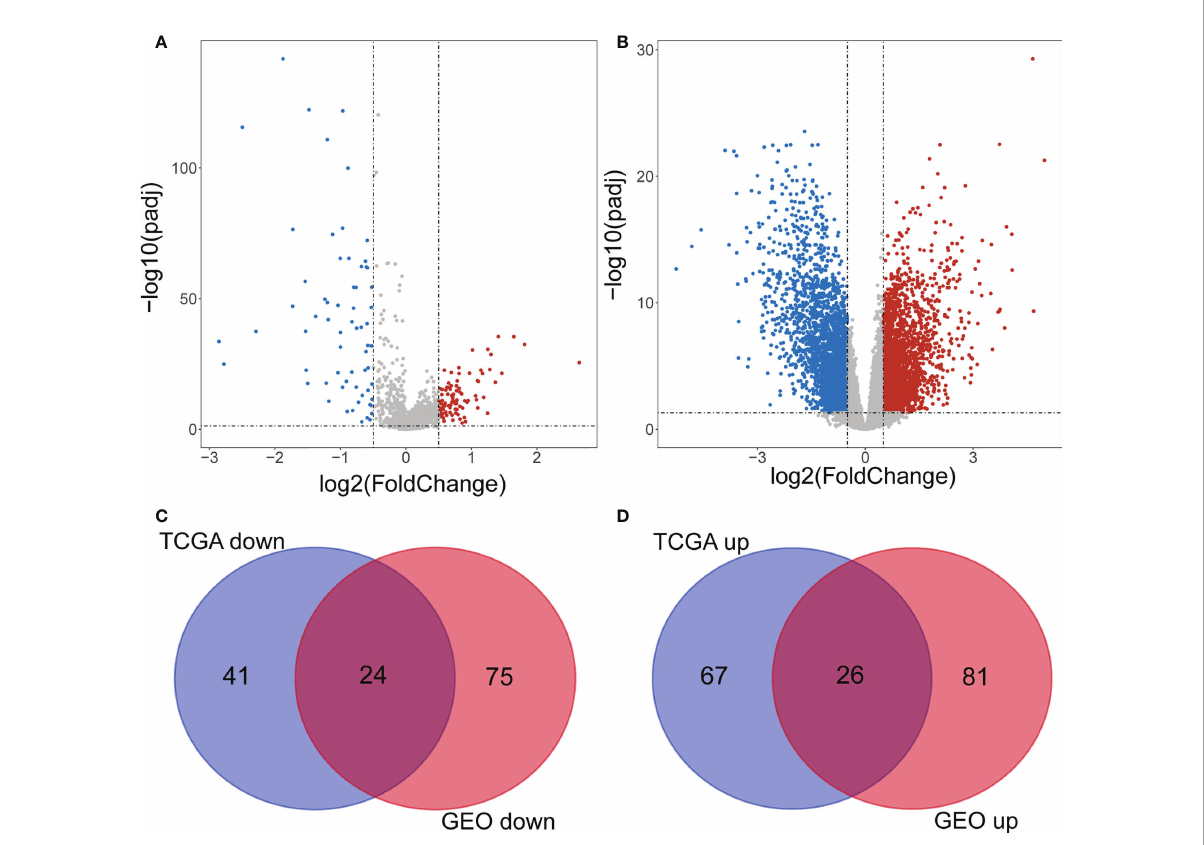
FIGURE 1 Screening differentially expressed IncRNAs. (A) Volcano plot of DE-IncRNAs from TCGA dataset. Red and green indicate up-regulated and down-regulated IncRNAs respectively. (B) Volcano plot of DE-IncRNAs from GEO dataset. Red and green indicate up-regulated and down- regulated IncRNAs respectively. (C, D) Venn diagram of the intersection of